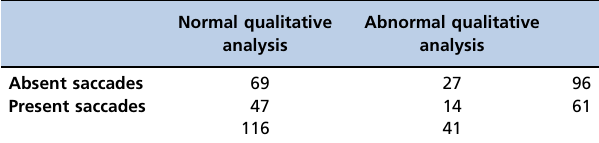
Table 6 - Comparison between the qualitative alterations of the CT and vHIT saccades. Normal qualitative Abnormal qualitative analysis analysis